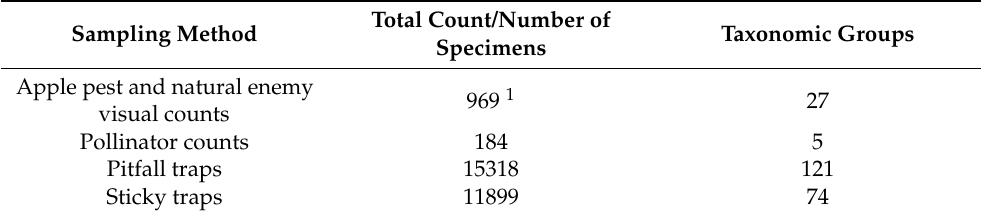
Table 3. Total numbers of invertebrate specimens and taxonomic groups counted from each sampling